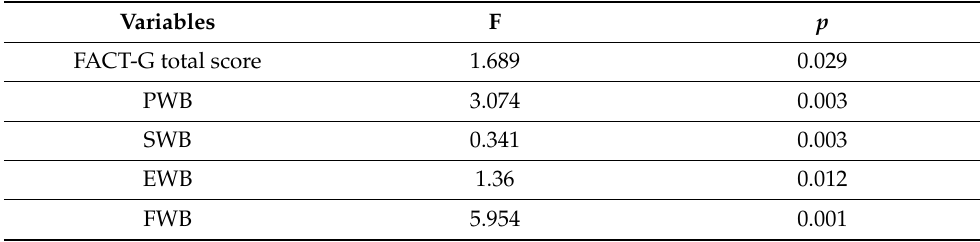
Table 2. Independent samples’ test.